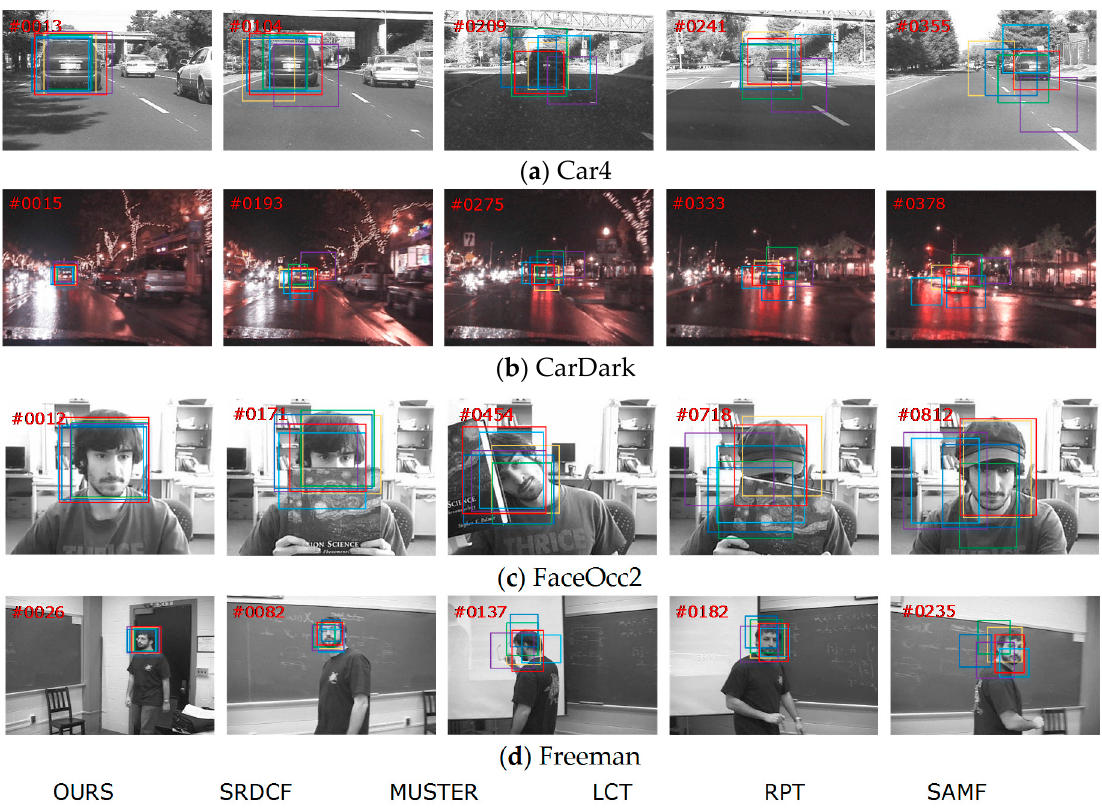
Figure 8. Tracking results of object undergoing severe occlusion, illumination, and in-plane rotation on OTB100. From top to bottom, the name of the video is ( a ) Car4; ( b ) CarDark; ( c ) FaceOcc2; ( d ) Freeman.